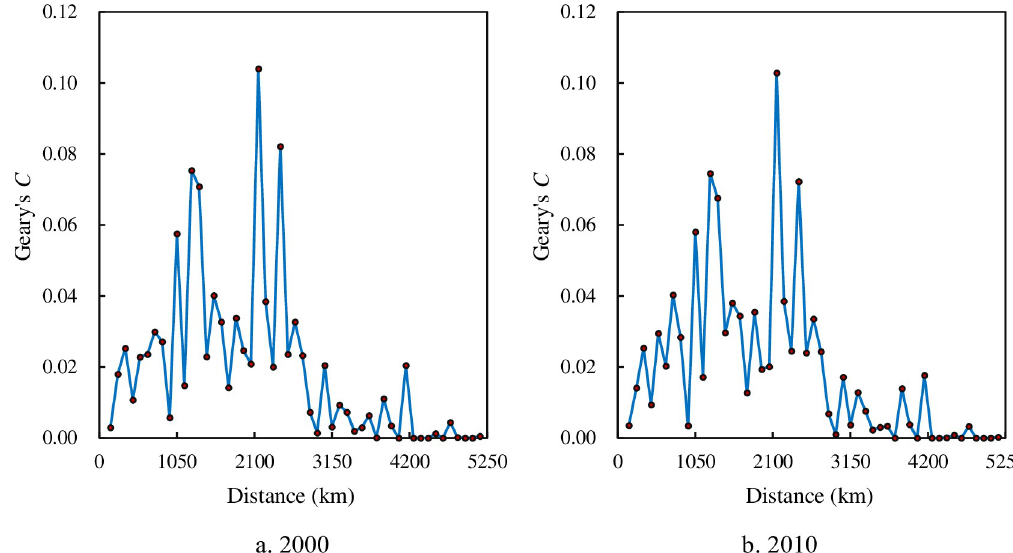
Fig 10. The curves of Geary’s C based on correlation density for the main cities of China. ( Note : Inside the scaling ranges of spatial correlation dimension, the curves of Geary’s C fluctuate sharply. From 2000 to 2010, the curve shapes have no significant change.).